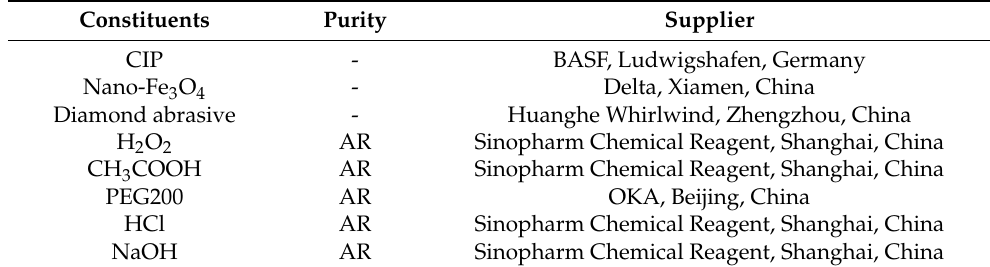
Table 1. Constituents used for configuring MRF fluid.